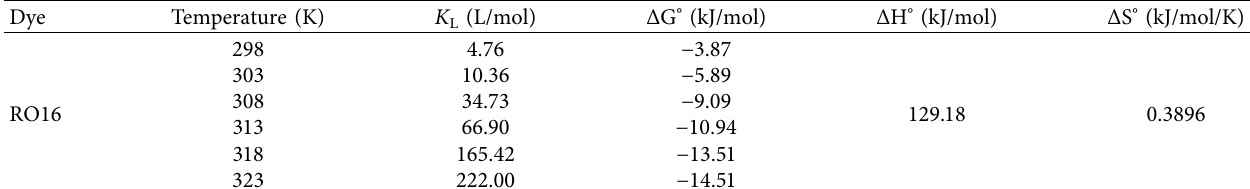
Figure 6: Observations on the elimination of RO16 using the PSO kinetic model. Table 5: Thermodynamic parameters for the sorption of RO16.